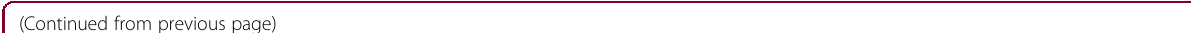
Algorithmic approaches and standardized IHC